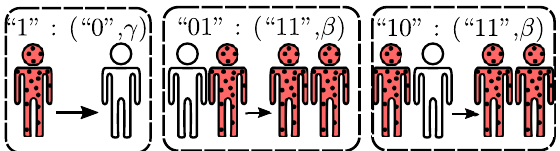
Figure 7. Off-diagonal transitions in the SIS model. Data structure follows the income-outcome convention.